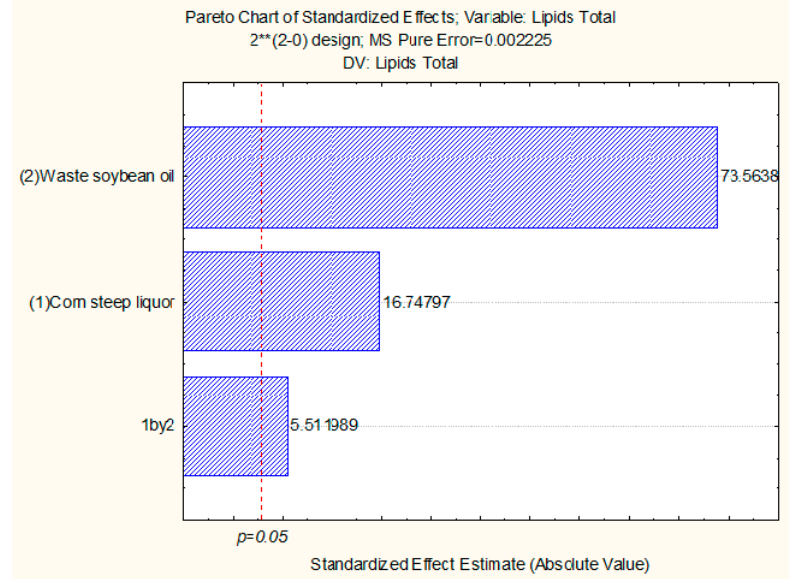
Figure 7. Pareto chart for 2 2 factorial design of culture of 96 h, where (1) corn steep liquor and (2) waste soybean oil are the independent variables and the total of lipids is the response variable. The point at which the effect estimates were statistically significant ( p = 0.05) is indicated by the dotted red vertical line .